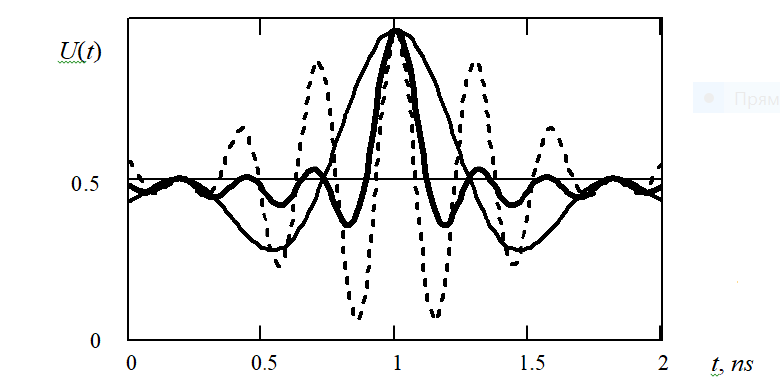
Fig. 4. The shape of the emitted and received